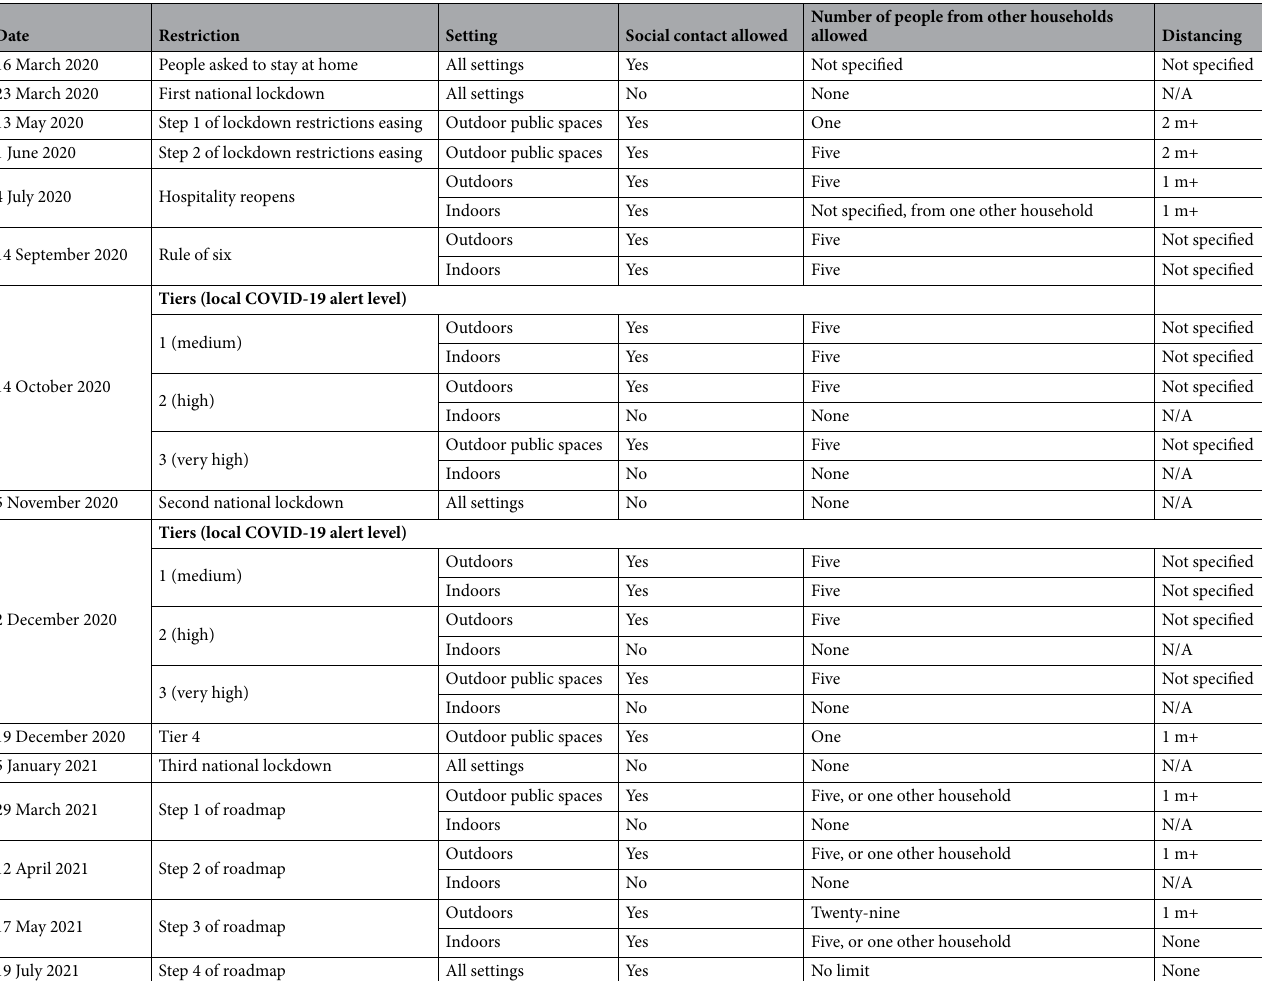
Table 1. Restrictions on social mixing in England during the pandemic (March 2020–July